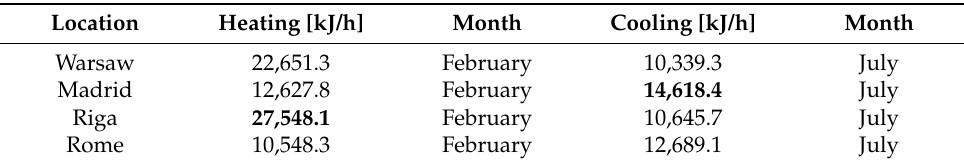
Table 2. Maximum values of the heating and cooling loads.